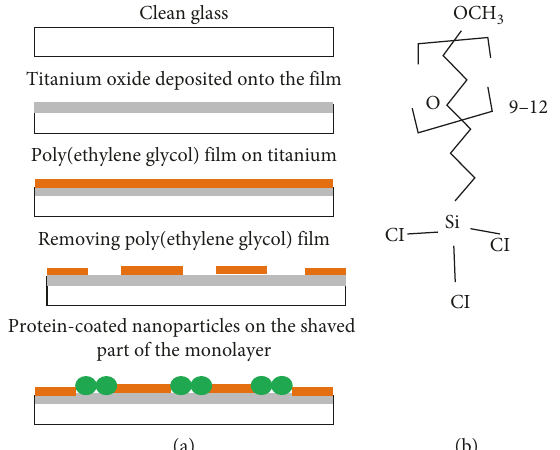
Figure 1: (a) Schematic showing the process of deposition of protein-coated nanoparticles. (b) Poly(ethylene glycol)-trichlorosilane molecule used for the formation of the monolayer.